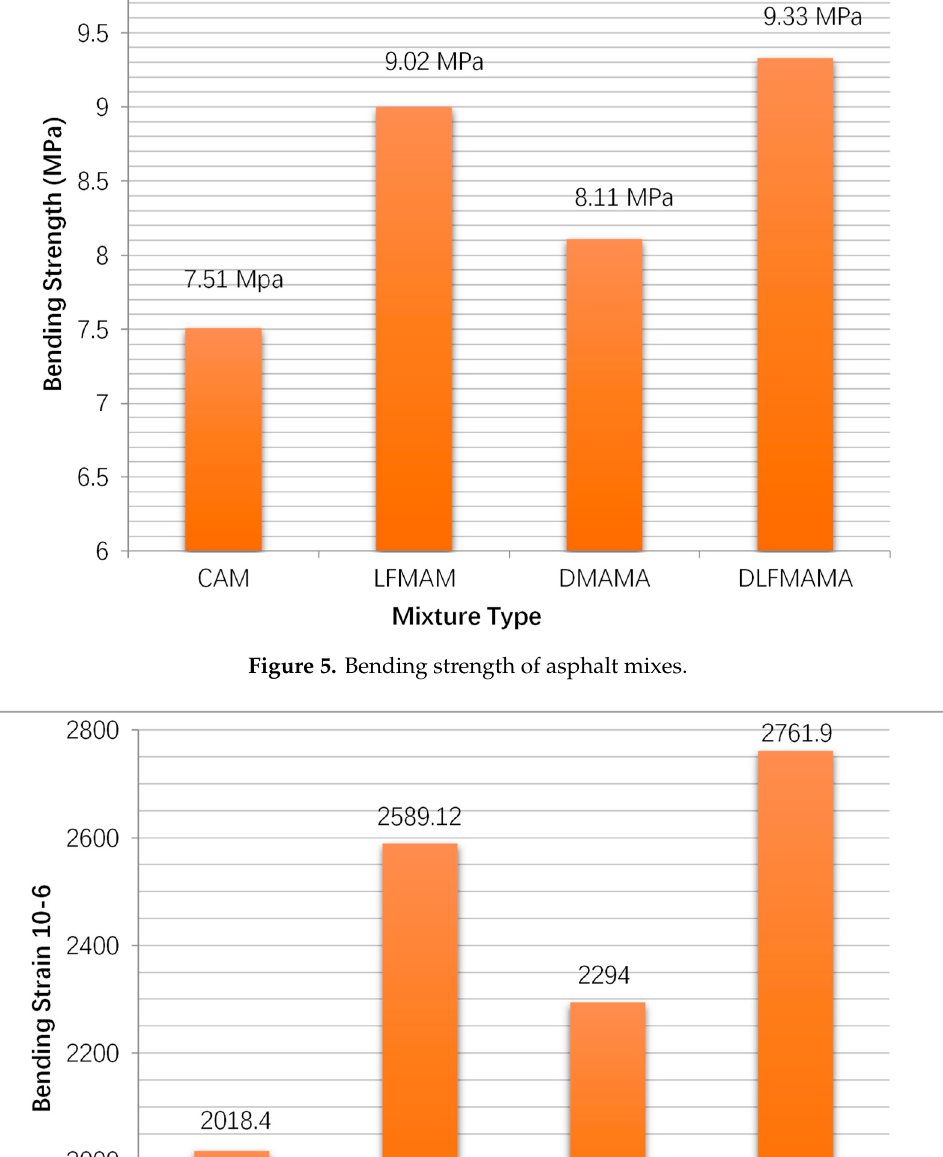
Figure 7. Crack and lignin fiber. 3.2. Water Stability Test Results 3.2.1. Marshall Immersion Test Results Results of immersion Marshall Stability values (MS1, MS2), and Residual Marshall Stability ratio (RMS) are summarized in Table 7 and Figure 8. Results indicated that the modified asphalt mixes containing not only lignin fiber but also diatomite powder had a higher resistance to moisture damage. The asphalt mixes modified with lignin fiber and diatomite improved the RMS to 7.11% and 9.14%, respectively, as compared to the control mix. Furthermore, the composite asphalt mixes of diatomite and lignin fiber (DLFMAM) achieved the greatest moisture susceptibility performance among the four types of asphalt mixes, with an increase of nearly 12.05% in RMS than that of control mix.